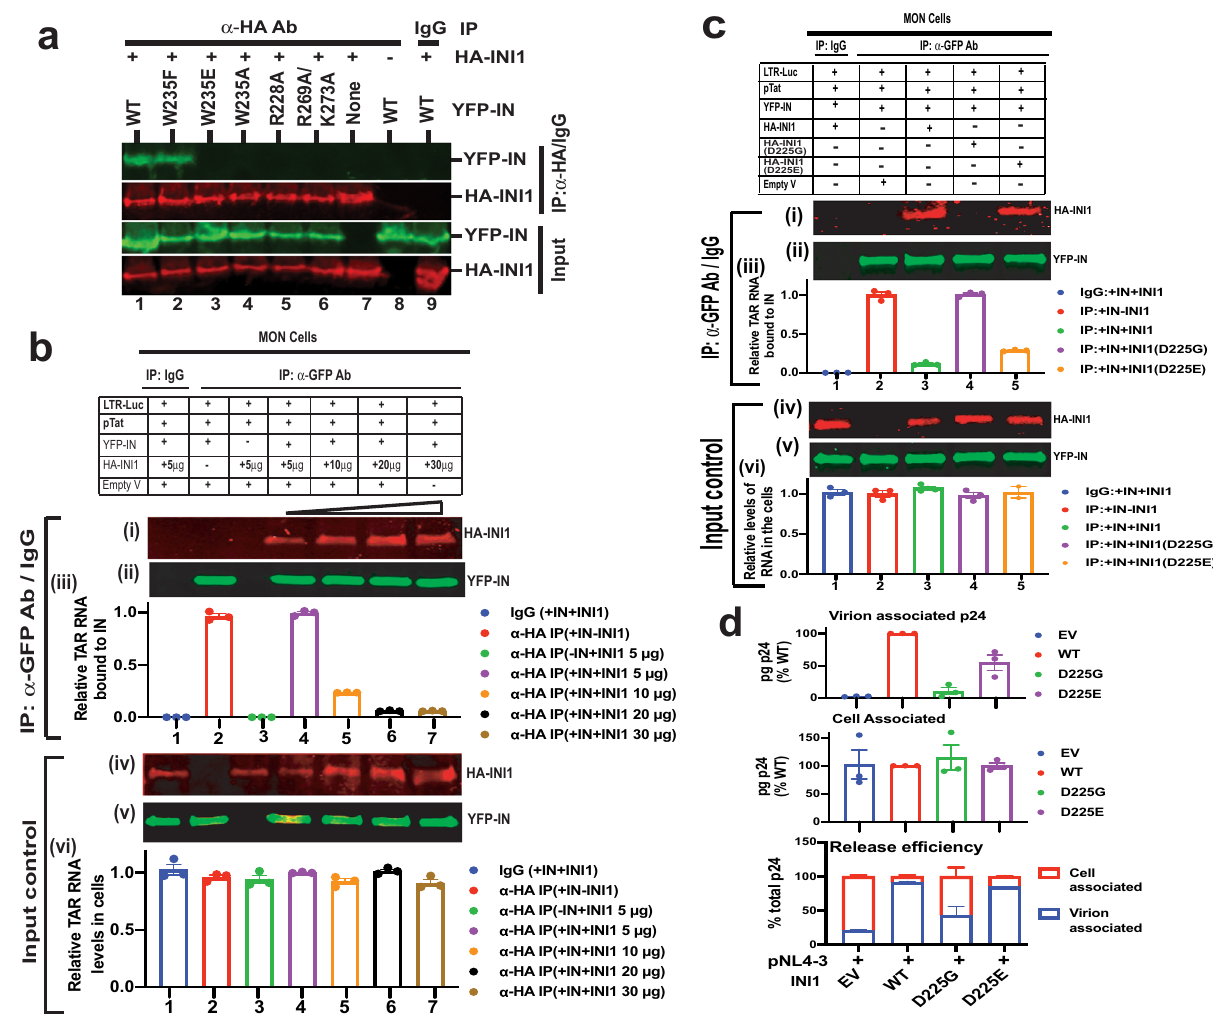
Fig. 5 INI1 competes with TAR RNA for binding to IN in vivo and facilitates particle production. a Co-immunoprecipitation of INI1 with IN and mutants in vivo. MON cells were transfected with YFP-IN/IN mutants and HA-INI1, and then subjected to co-immunoprecipitation using α -HA antibodies. Representative images from one out of three independent experiments is shown. The top two panels illustrate results of co-immunoprecipitation using α -HA antibodies. The lower two panels represent the input control. Lanes 7-9 represent controls, use of isotype IgG antibody (lane 9) or lack of INI1 or IN (lanes 7-8). b RNA-co-IP analysis to determine the competition of INI1 and TAR RNA for binding to IN. The gel images are from one out of three representative experiments. The top three panels (i) – (iii) represent the RNA and proteins present in the immune complexes and the bottom three panels (iv) – (vi) represent proteins and RNA in the input controls. Panels (iii) and (vi), graphic representation of relative amounts of TAR RNA bound compared to control, as determined by qRT-PCR ( n = 3 independent experiments), normalized to control (lane 2). Immunoprecipitation was carried out using isotype IgG antibody (lane 1) or α -GFP antibodies to pull down YFP-IN (lanes 2-7). Lane 3 represents negative control without YFP-IN. Lanes # 4-7 represent RNA- co-IP in the presence of increasing HA-INI1. c IN-interaction-defective INI1 mutant do not compete with TAR in vivo. The gel images are from one out of three representative experiments. Panels (i) – (vi) are as in b . Lanes represent results of RNA-co-IP of YFP-IN with TAR RNA in the presence of WT INI1 (lane 3), INI1(D225G) (lane 4), and INI1(D225E) (lane 5). d INI1 binding to IN is necessary for particle production. The top panel represents virus- associated and the middle panel represents the cell-associated p24, expressed as % of wild type. The bottom panel represents release ef fi ciency as a fraction of viral- and cell-associated p24 of each mutant, as compared to wild type, expressed in %. EV = Empty vector; WT = wild type. The bars represent the average of three independent experiments (Mean ± SEM). The bars are color-coded as indicated in the key provided next to the graph. Uncropped gels/blots for all the images in this fi gure are provided in the source